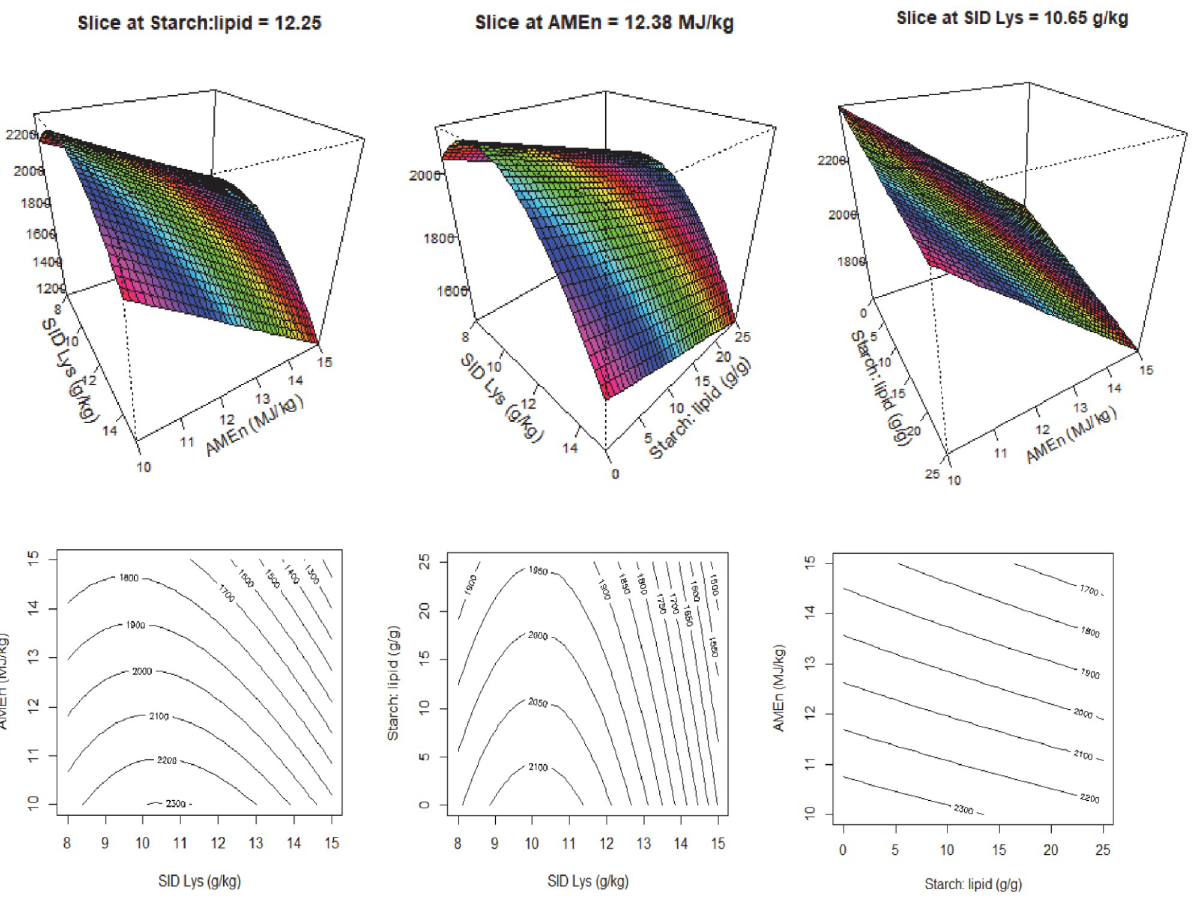
Fig 1. Response surface and contour plots describing relationships between feed intake (g/bird) and digestible lysine concentration (SID Lys), energy density (AMEn) and starch to lipid ratios (S:L) in broiler chickens from 21–35 days post-hatch.